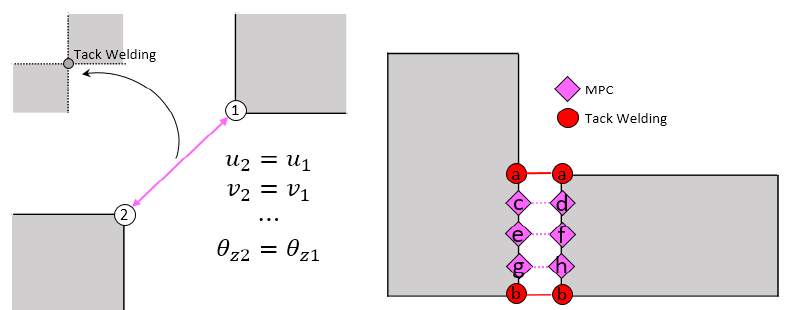
Figure 4. Application of multipoint constraint function.